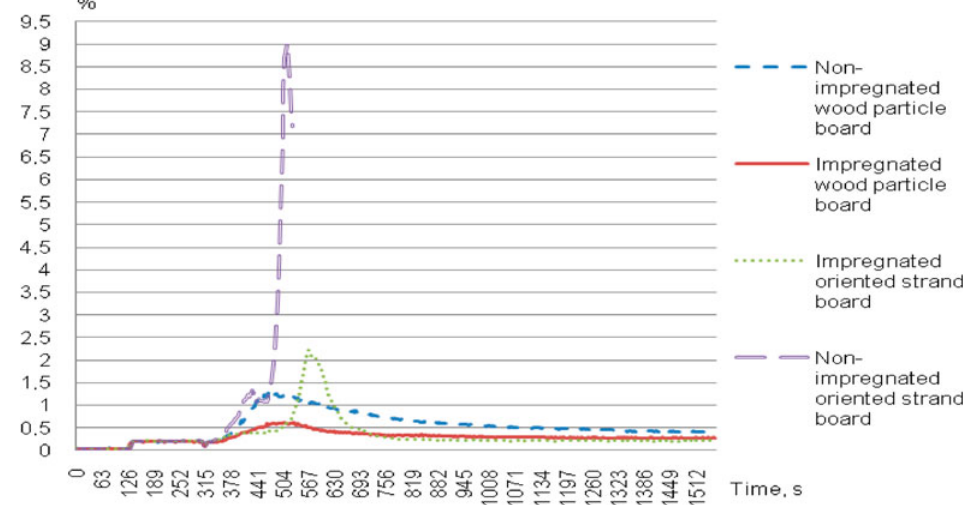
Fig. 9. HRR of impregnated 6 mm